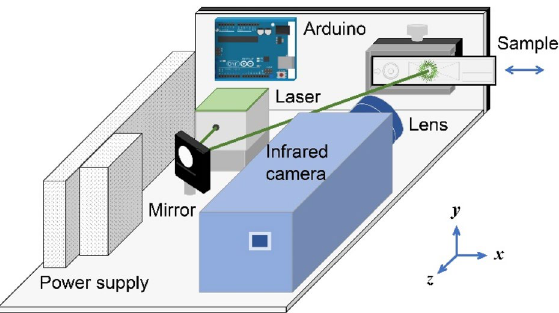
Figure 2. Instrument layout of the TLFIA reader. Major components of the instrument are labeled in the figure and described in text. The instrument is portable, having dimensions of 32 cm (length) × 20 cm (width) × 12 cm (height).